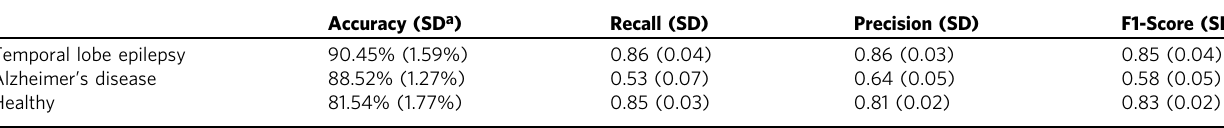
Table 2 Disease-dependent model evaluation